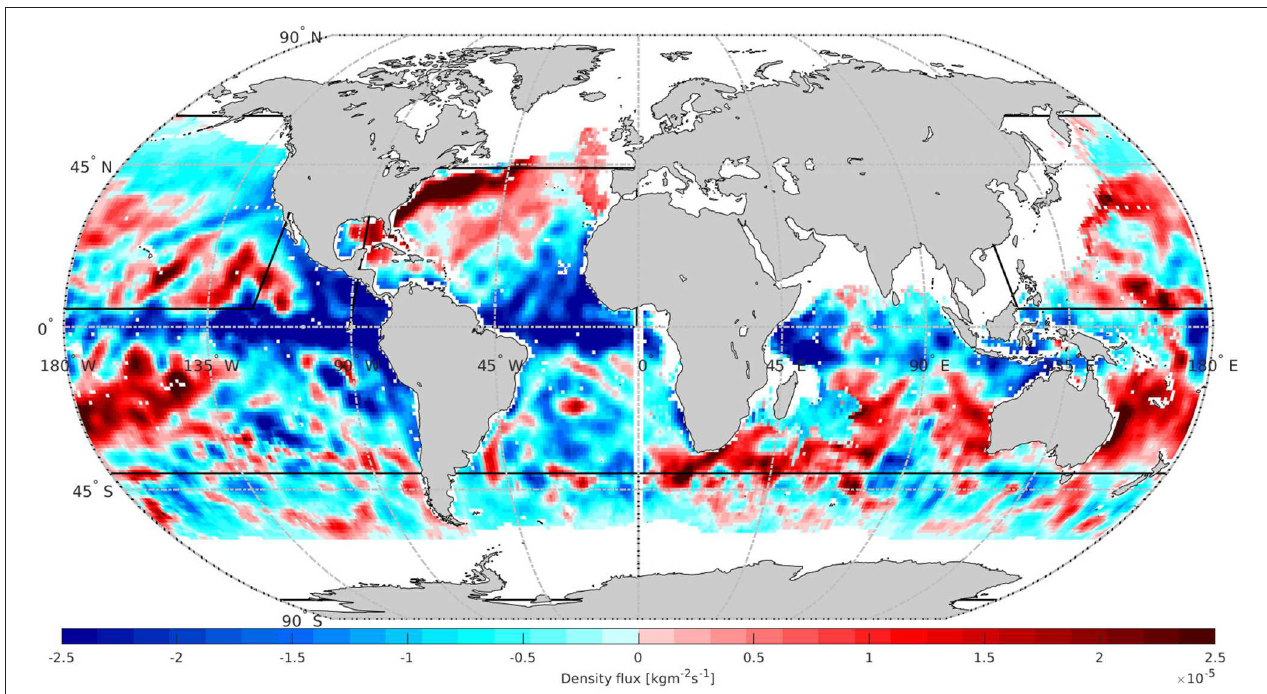
FIGURE 2 | Annual averaged surface density flux for the year 2012 calculated using SMOS SSS and OSTIA SST. The black boxes represent the boundaries defined for the North Atlantic (0 ◦ –44 ◦ N, 90.5 ◦ –0.5 ◦ W), the North Pacific (5 ◦ S–59 ◦ N, 120 ◦ –240 ◦ E) and the Southern Ocean (79.5 ◦ –40.5 ◦ S, with longitudes encircling the entire Southern Ocean). Missing density flux estimates (indicated in white) are related to issues of satellite salinity retrieval due to Radio Frequency Interference or signal contamination from land